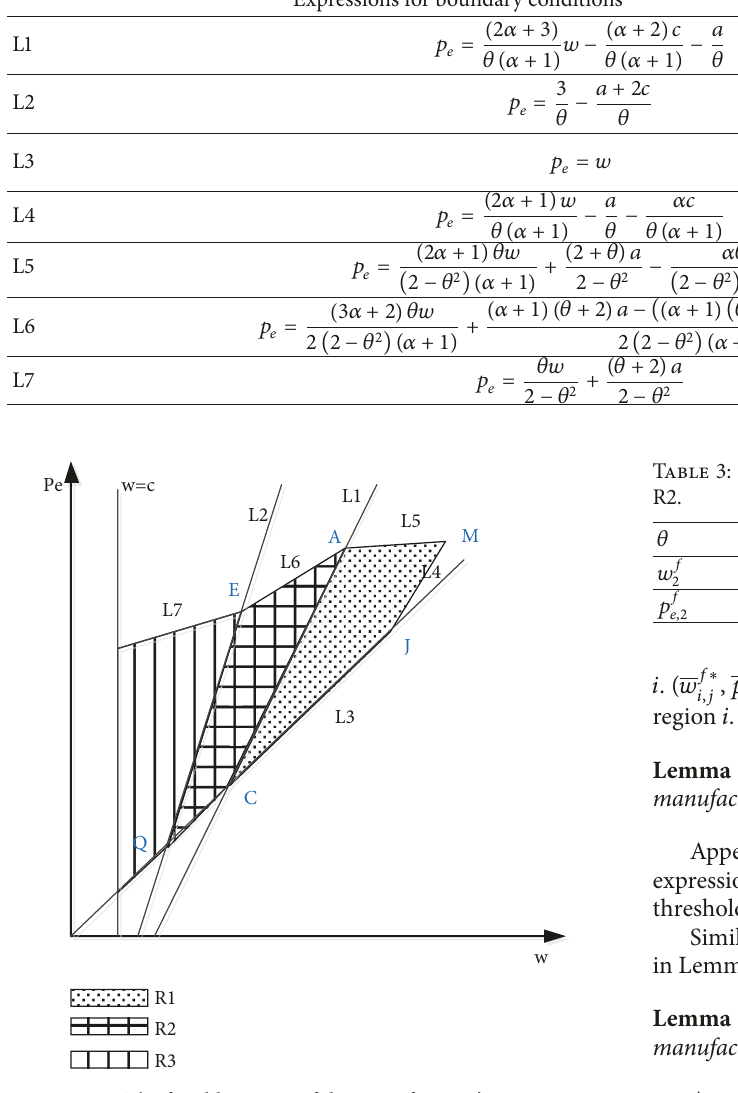
Figure 2: The feasible region of the manufacturer’s strategies.